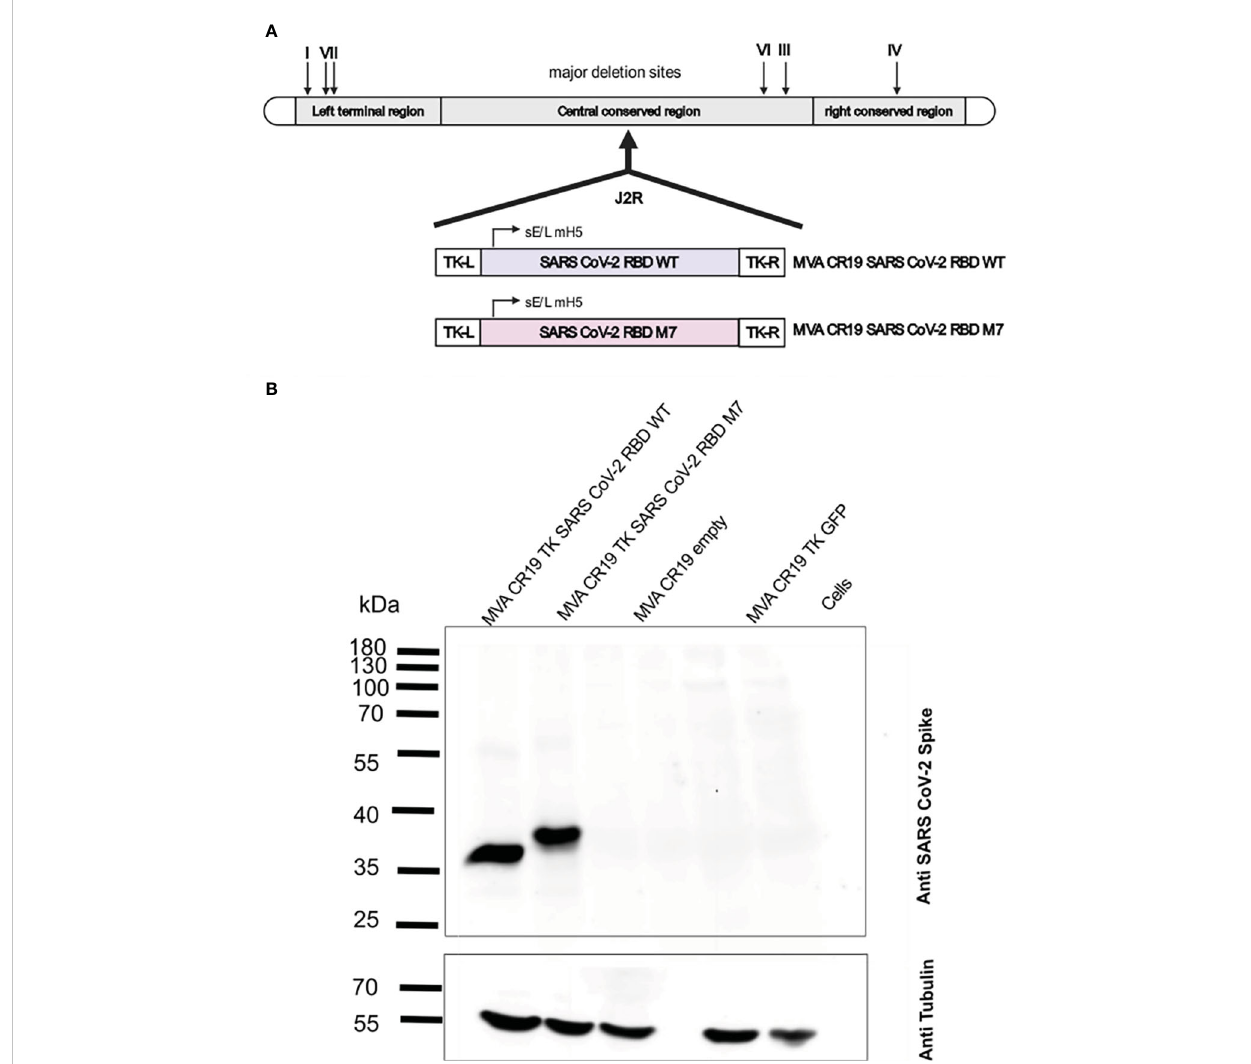
FIGURE 3 Construction and biochemical characterisation of recombinant MVAs encoding for SARS CoV-2 RBD WT and SARS CoV-2 RBD M7 antigens. (A) Schematic representation of the MVA genome and design of the recombinant SARS CoV-2 RBD WT and SARS CoV-2 RBD M7 MVAs. The J2R region or TK locus was used to insert the antigens for SARS CoV-2 RBD WT and SARS CoV-2 RBD M7 via homologous recombination. (B) Western blot analysis of recombinant MVAs encoding SARS CoV-2 RBD WT and SARS CoV-2 M7 RBD using HEK293T cell lysates infected with a MOI of 2.0 and harvested after 24 h. Size in kilodaltons (kDa) and corresponding bands of the protein standard are indicated. The “ MVA CR19 empty ” lane represents cells infected with the same MVA construct, but lacking the antigen gene in the backbone, the “ Cells ” lane represents uninfected